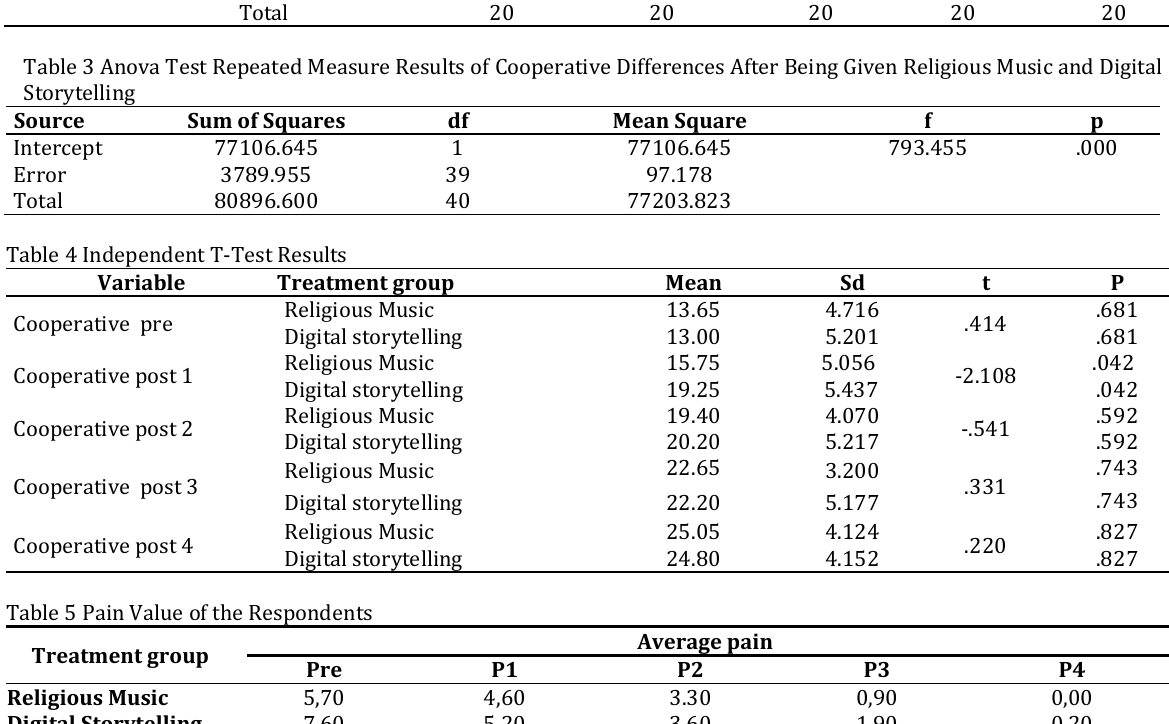
Digital Storytelling